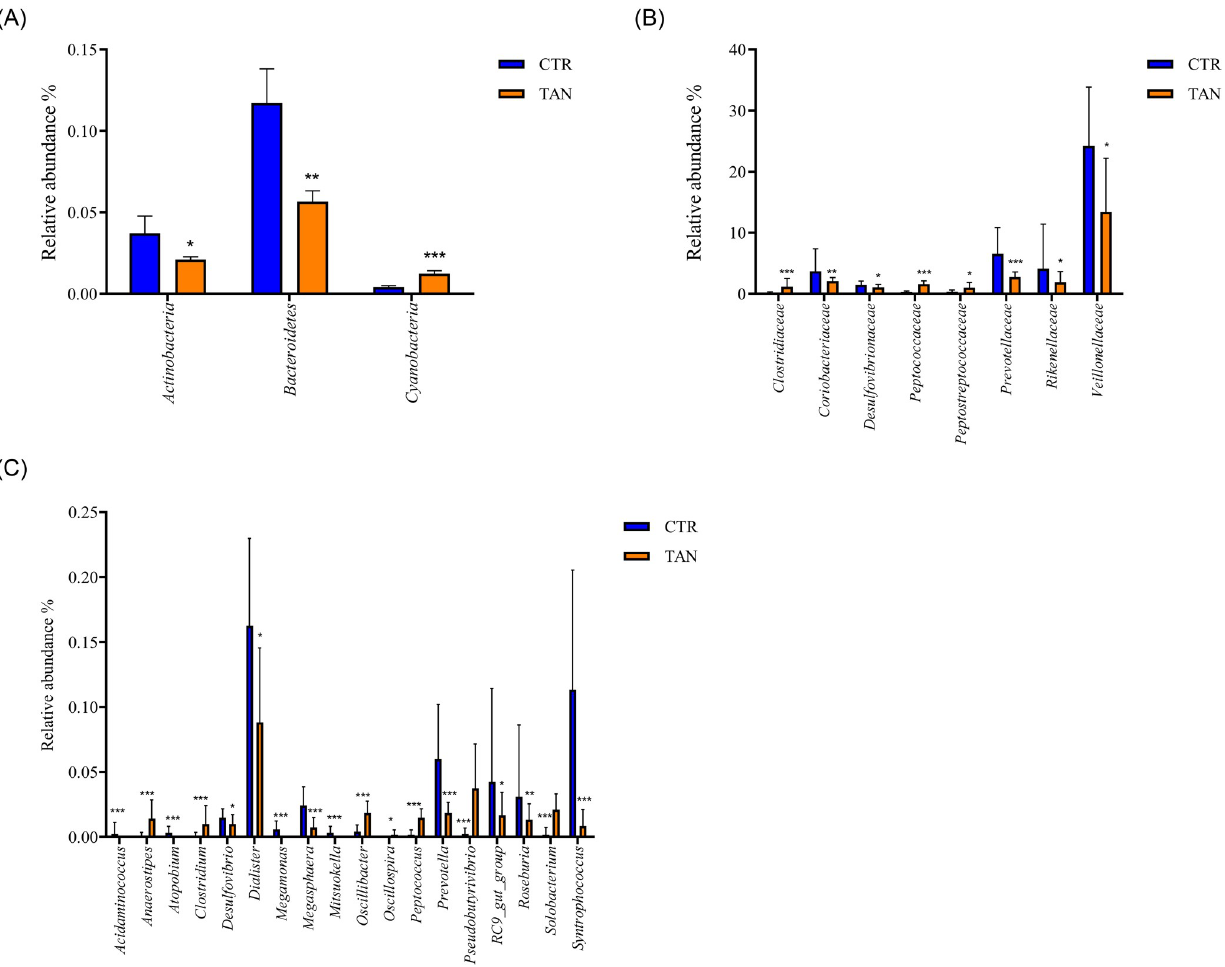
Fig 3. Relative abundance of fecal bacterial populations at phylum (A), family (B) and genus (C) levels in tannin-fed (TAN) and control (CTR) piglets. Only taxa with a mean relative abundance higher than 0.002% are shown. p value significance levels were reported as � p � 0.05; �� p � 0.01; ��� p �